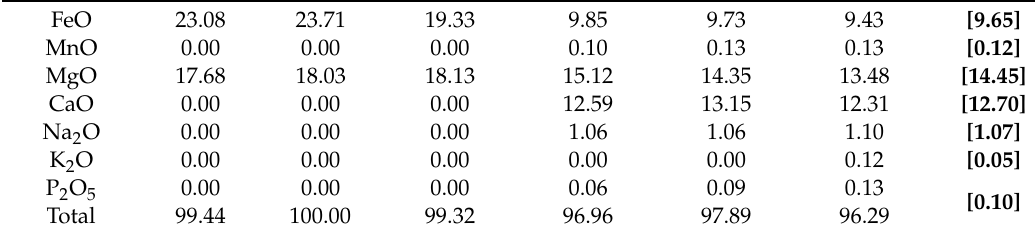
pattern, with a relatively long descending limb (Figure